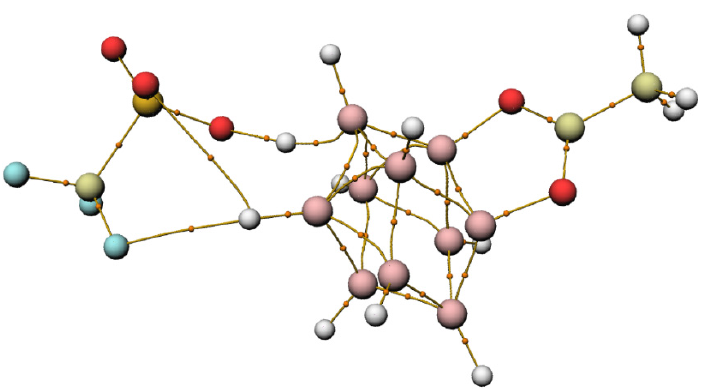
Figure 3. Molecular graph showing the results of the topological analysis of the electron density distribution in the model structure of TS. Atomic designations are given in Figure 2.